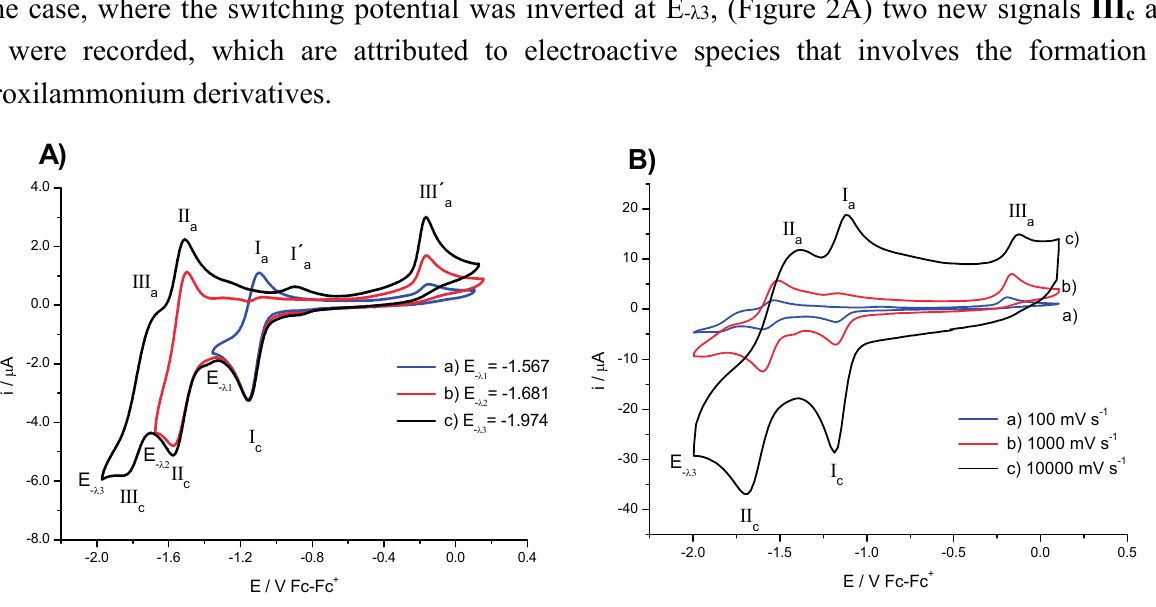
Figure 2. Cyclic voltammogram of compound 4 in the presence of 0.1 M TBAPF 6 in DMSO, with scan rate of 100 mV·s − 1 . ( A ) The scan was initiated form E i = 0 inverted at (a) E λ 1 and at (b) E λ 2 and (c) E λ 3 ; ( B ) Behaviour of cyclic voltammograms at scan rate (a) 100 mV·s − 1